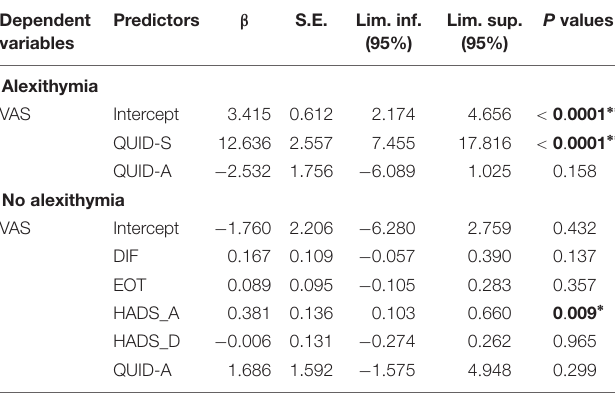
TABLE 8 | Results of multiple regression analysis predicting pain intensity (VAS) from DIF, EOT, HADS-A, HADS-D in alexithymic ( n = 40) and non-alexithymic patients ( n =